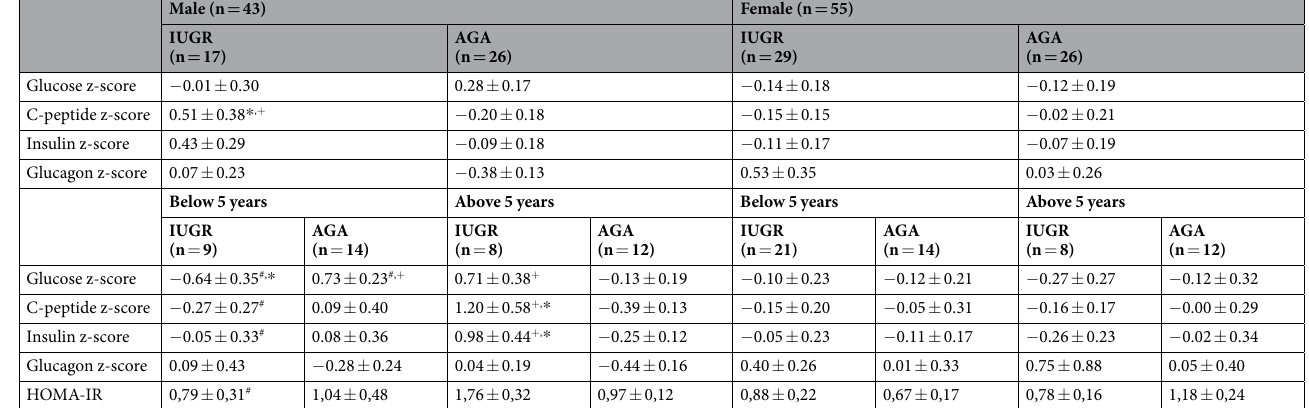
Table 5. Comparison of glucose metabolism and hormone parameters between children born IUGR and AGA at the observation time expressed as mean ± S.E. Statistical comparisons were performed with multiple factors ANOVA. * denotes statistically significant difference from the respective AGA group. # denotes statistically significant difference from the respective group aged > 5 years old. + denotes statistically significant difference from the respective female